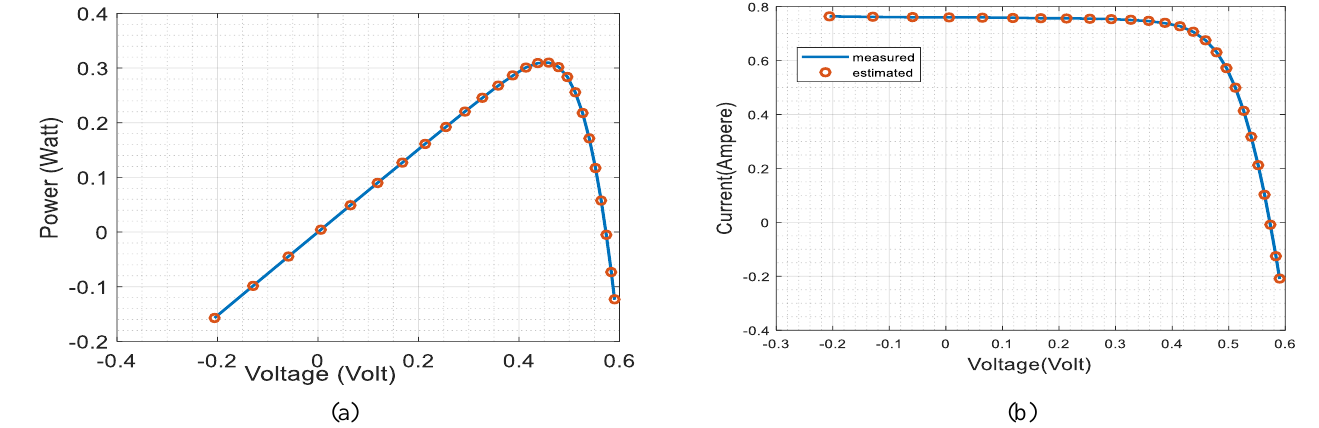
Fig. 4. (a) P-V and (b) I-V curves for Double Diode Model based on parameters estimated from PSO